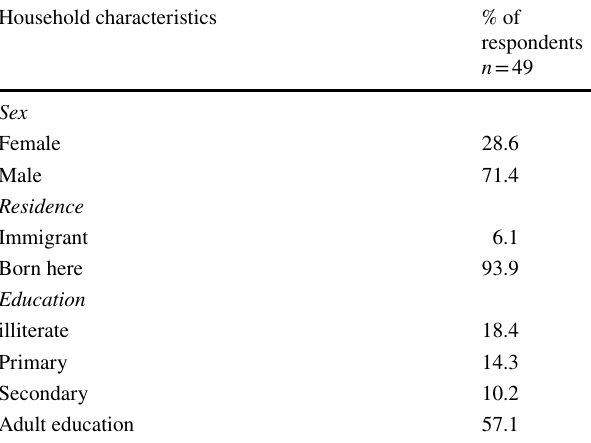
Table 9 Demography of households dwelling in Wondo Genet